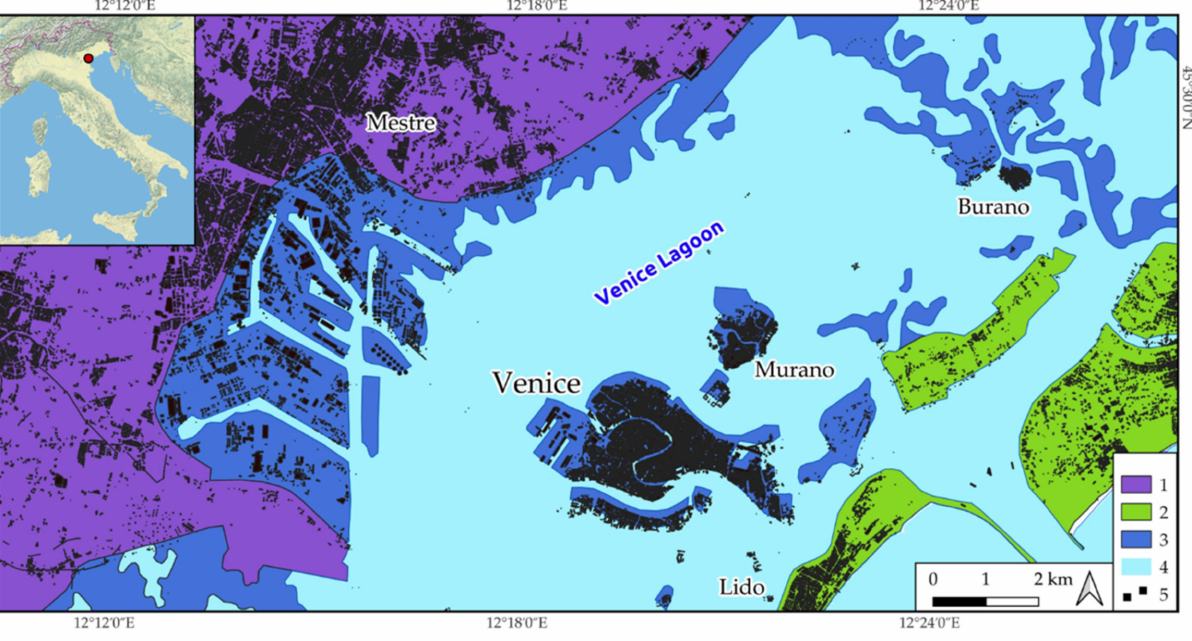
Figure 4. Geological sketch map of the study area of Venice Lagoon (red dot in the upper image): (1) Alluvial deposits; (2) Tidal deposits; (3) Littoral deposits; (4) Venice Lagoon and Adriatic Sea; (5) Buildings. Modified from